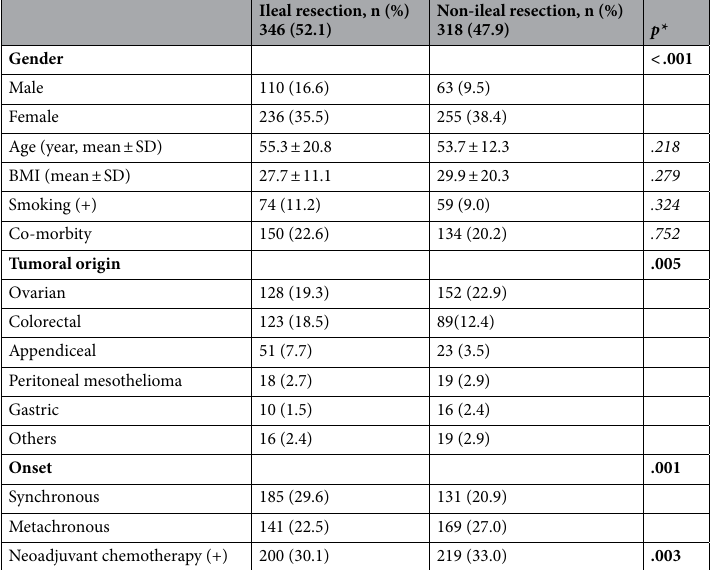
Table 1. Clinical and demographic characteristics of the patients. Bold values indicated statistical significance ( p < 0.005). BMI body mass index. *Pearson χ 2 test and independent samples t -test. Significant values are in